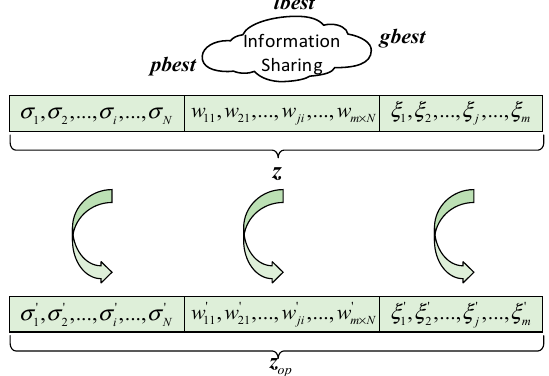
z . Figure 5. The schematic optimization process for obtaining z op op